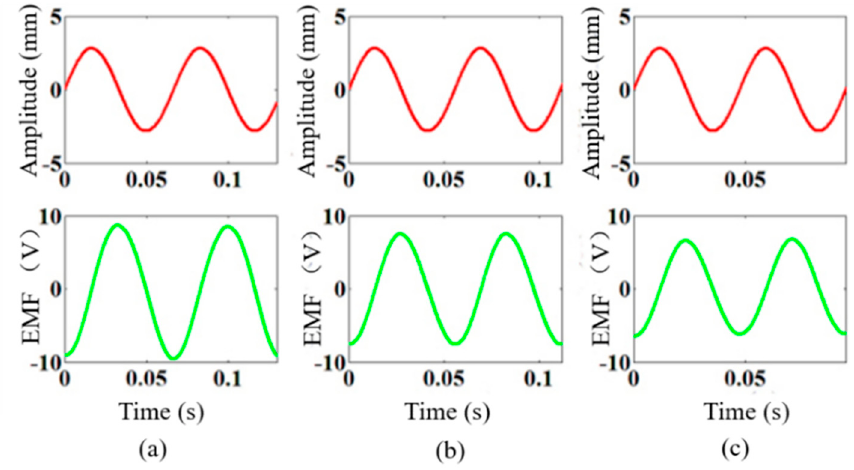
Figure 12. Effect of the excitation frequency on the EMF: ( a ) 15 Hz; ( b ) 18 Hz; ( c ) 21 Hz. The simulation results of the induced EMF are 7.3 V, 8.4 V, and 7.5 V in